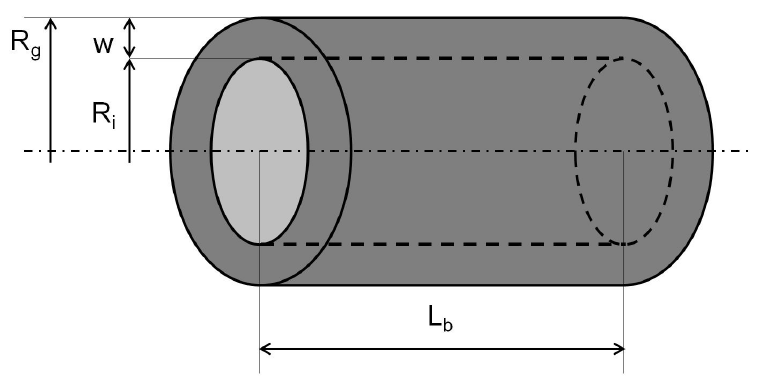
Figure 1. Schematic of the grain